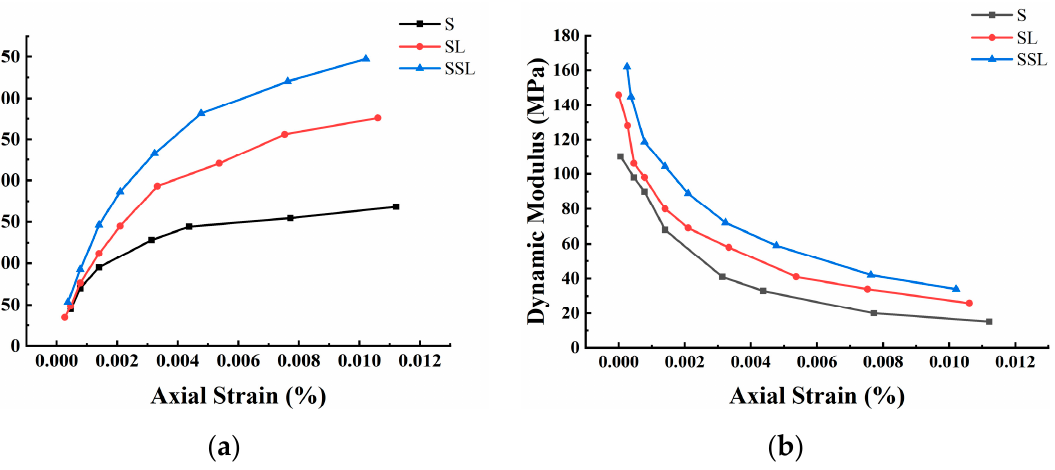
Figure 11. The dynamic modulus test results: ( a ) dynamic stress-strain curve; ( b ) dynamic re-bound modulus curve.